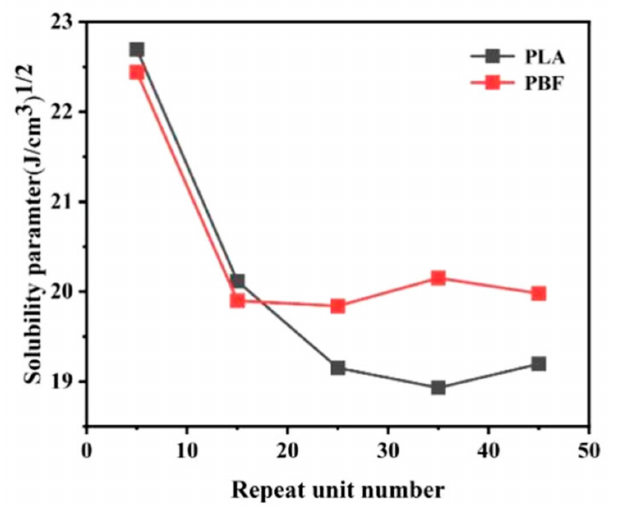
Figure 3. Relationship between the number of repeat units and solubility parameters of PLA and PBF.